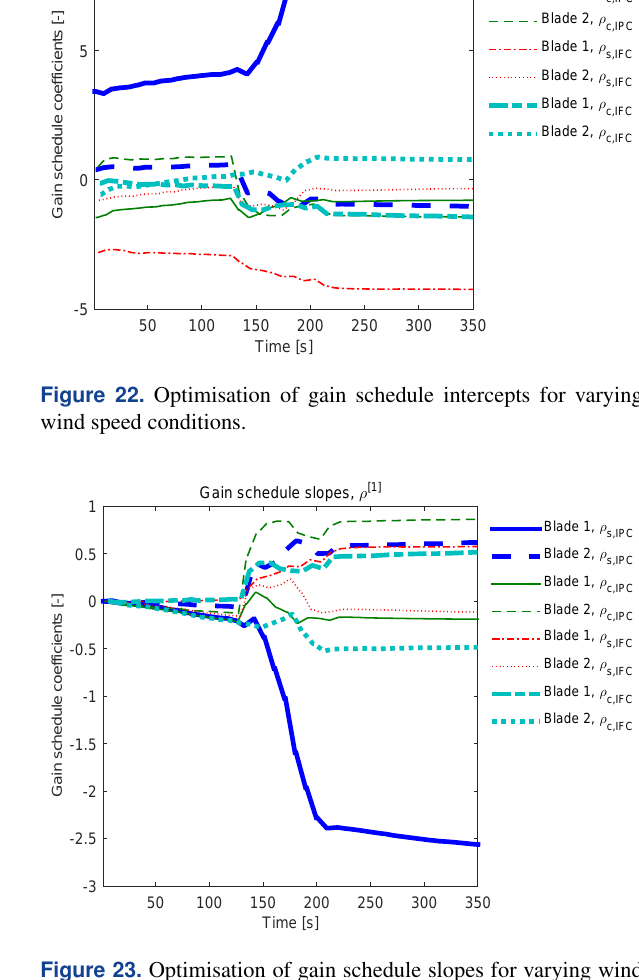
Figure 25. Gain schedule at varying wind speeds versus optimal gains at constant wind speed: flap